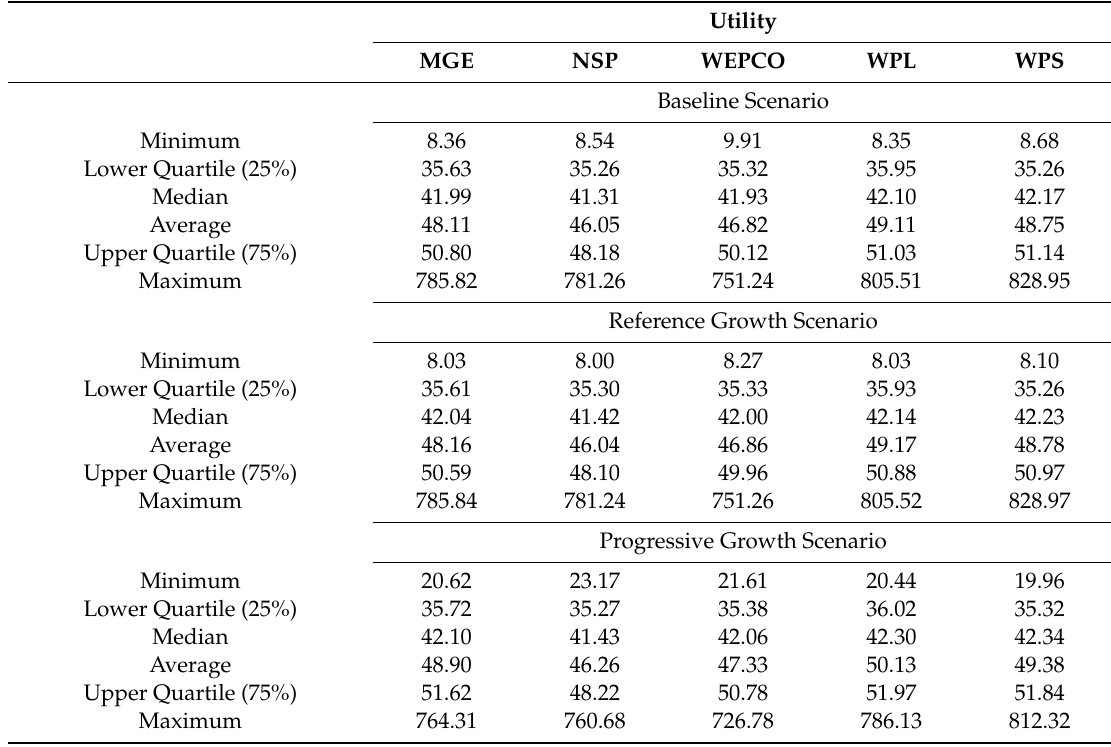
Table 4. Statistics of modeled hourly LMPs ($ / MWh) for each utility in Wisconsin in 2030 under the three growth scenarios.